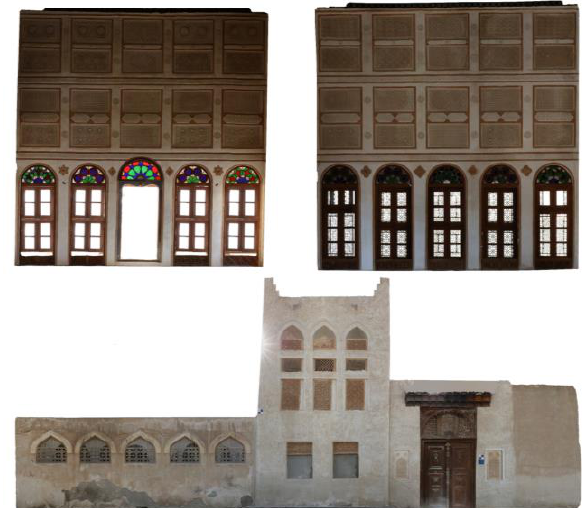
Figure 9 Samples of orthophotos generated from rectified photography and from the point cloud. Software employed Adobe Photoshop, Agisoft Photoscan and Perspective Rectifier. Images source: Authors and BACA staff.